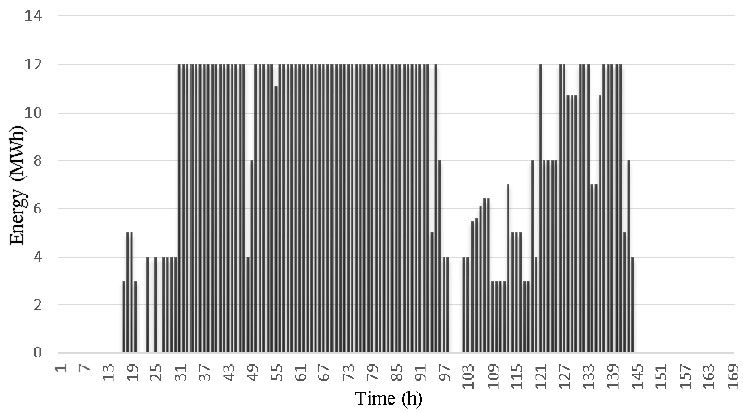
Figure 8. Energy purchased from the Bilateral 1 contract under the fourth scheme.